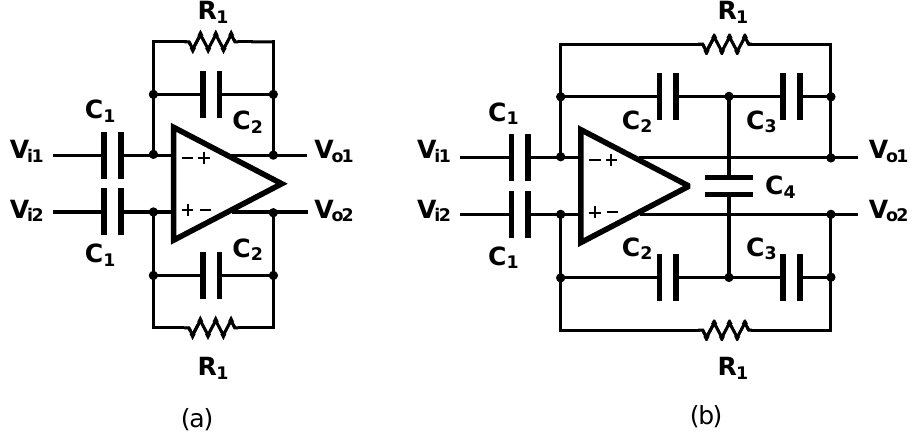
Figure 14. Overview of the ac-coupled capacitive-feedback structure for neural amplifiers. ( a ) Classical feedback topology and ( b ), capacitive T-feedback